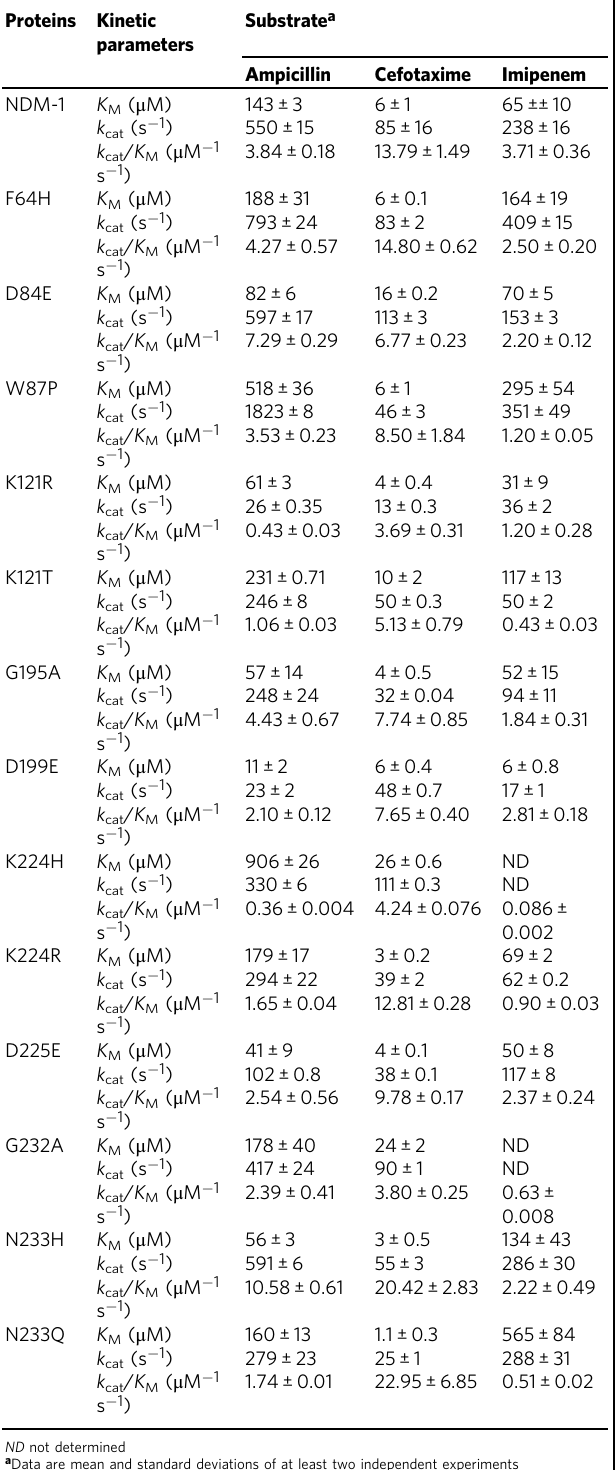
Table. 2 Enzyme kinetic parameters for NDM-1 and mutants Proteins Kinetic Substrate parameters